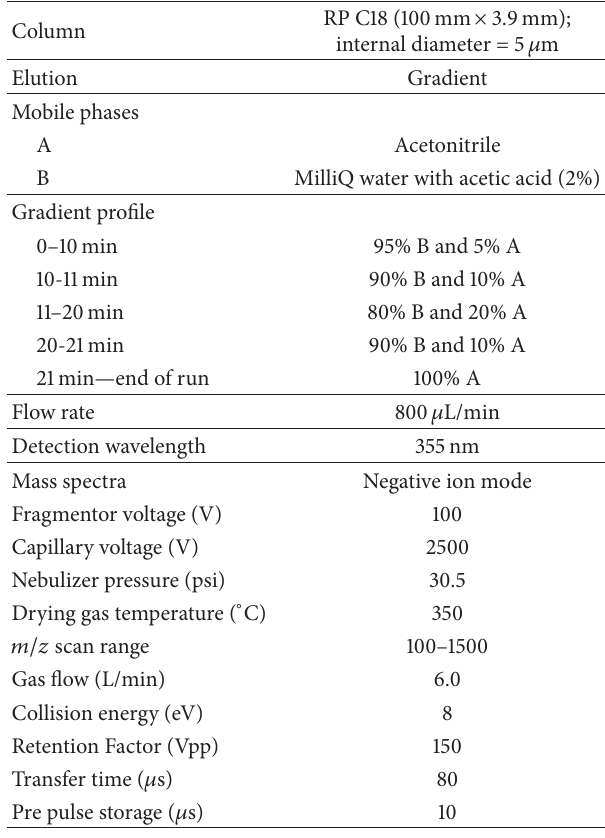
Table 1: Experimental conditions used for LC-MS/MS analysis of Triphala